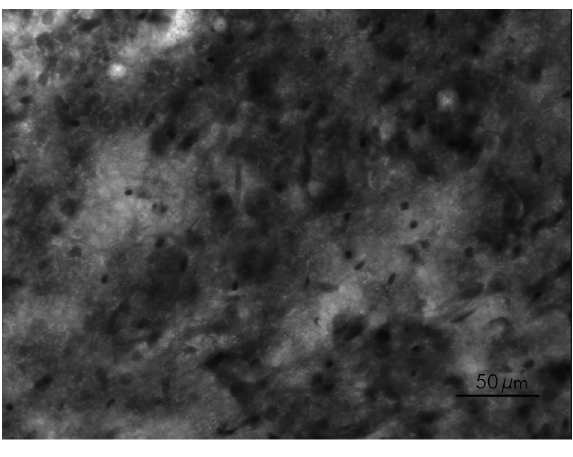
Figure 5. Presence of multinucleated atypical cells on the smears, with a sugestive report of mesenchimal malignat neoplasia (Papanicolaou